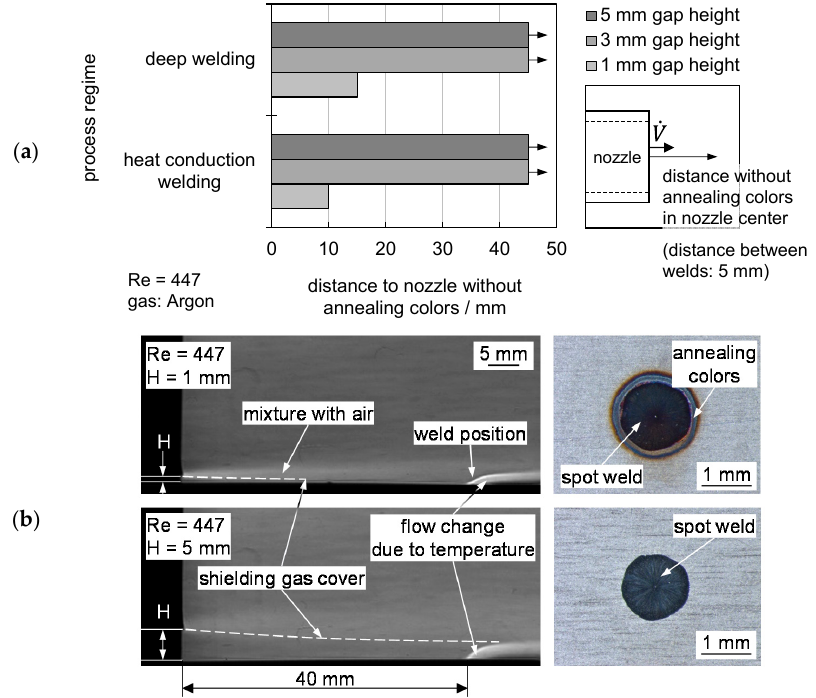
Figure 11. ( a ) Effect of gap height H on shielding gas coverage; ( b ) Schlieren images in heat conduc- tion welding at different gap heights H .